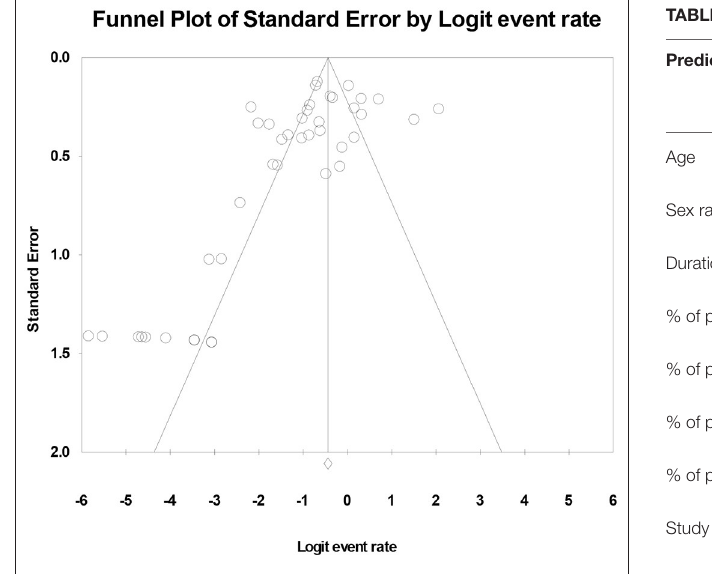
FIGURE 2 | Publication bias for the composite analysis on experimental treatments.